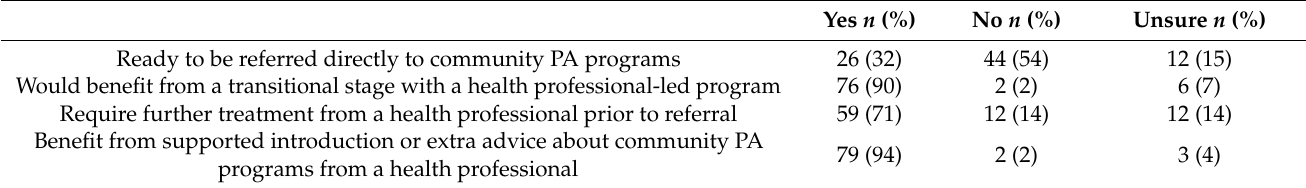
Table 3. Physiotherapist perceptions of patients’ readiness for structured community-based physical activity ( n =